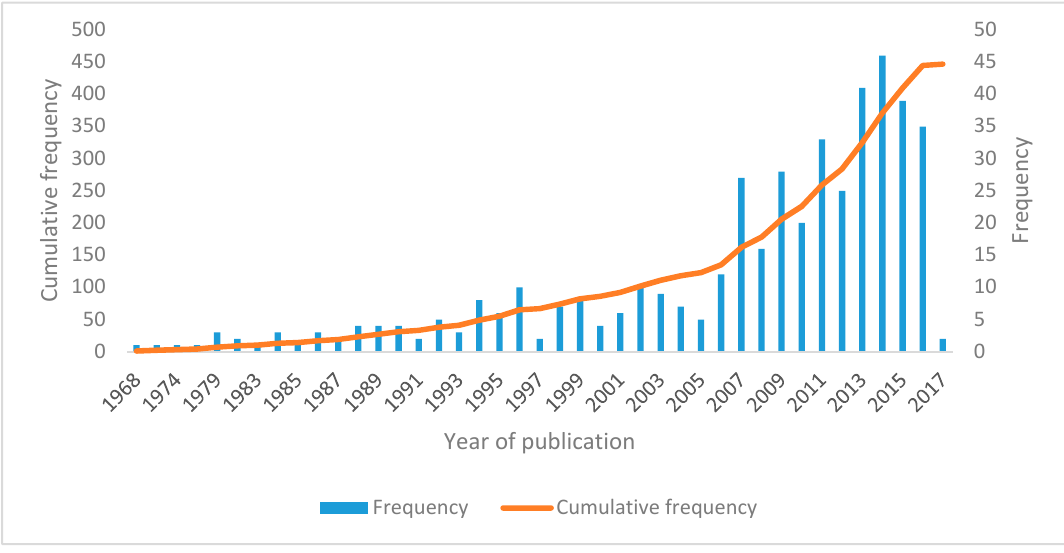
Figure 3. Yearly publication of peer-reviewed tobacco control studies in Sub-Saharan Africa (SSA) (up to February 2017; n = 447).